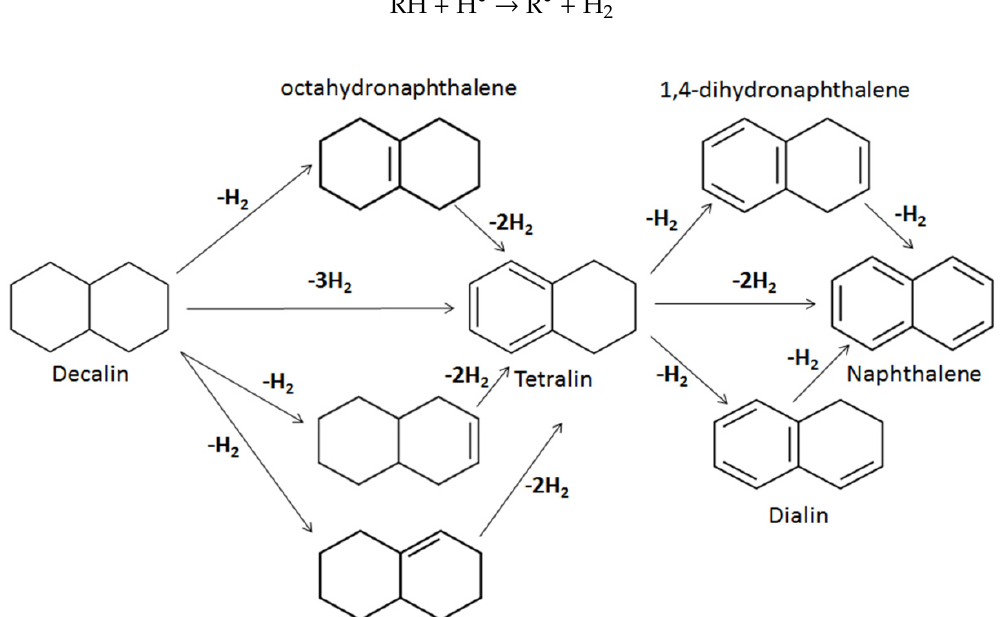
Scheme 1. Dehydrogenation routes for hydrogen liberation.